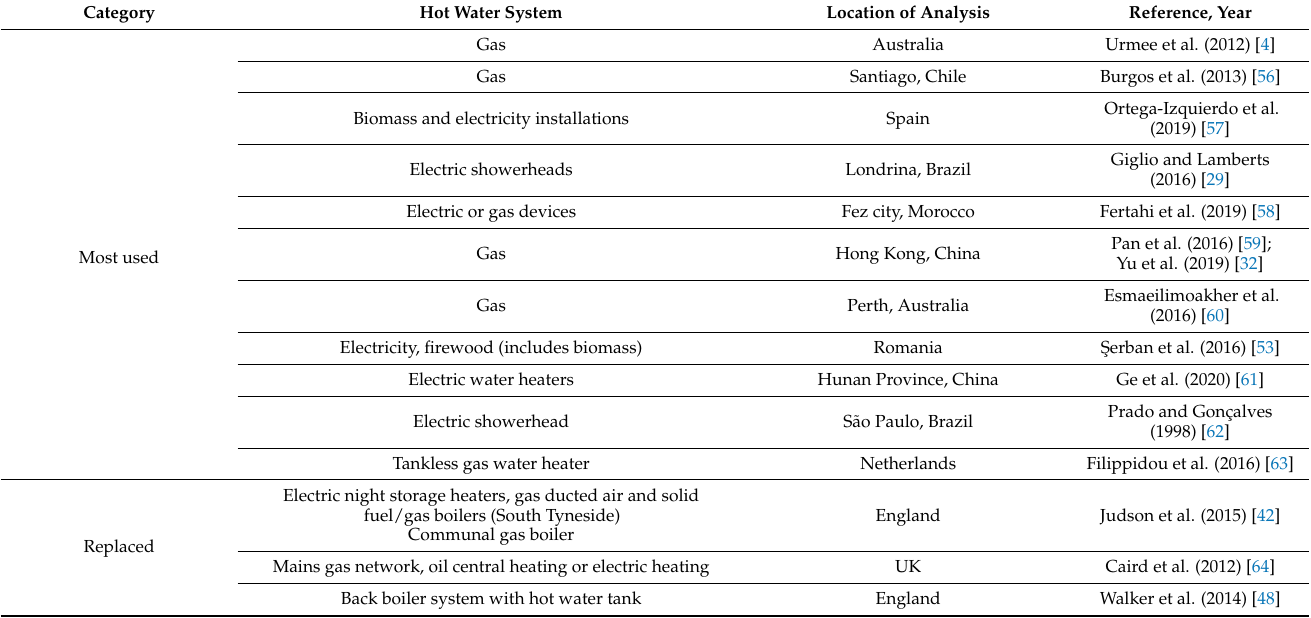
Table 4. Water-heating technologies mentioned in the